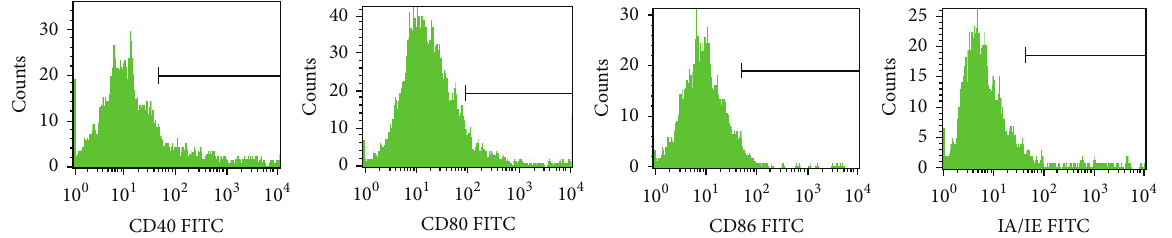
Figure 5: FACS analysis of BMDC surface antigen’s expression in MTX combined with CTX group on 9th week. CD40 59.4%, CD80 79.0%, CD86 66.1%, and MHC-II 69.6%. Data represented one of at least three independent experiments with 5